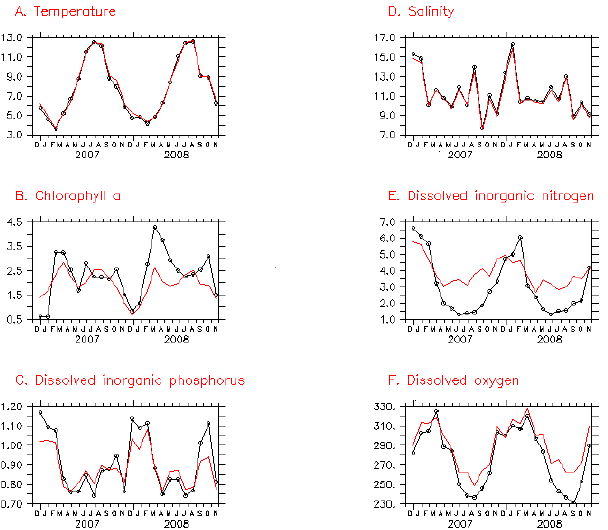
Fig. 14. Overall pattern of seasonal variability. Red solid curve (black dashed cycles) for model results (observations). Panels (A– F) for, temperature, Chl a , DIP, salinity, DIN, DO, respectively. Units same as in Fig. 13.